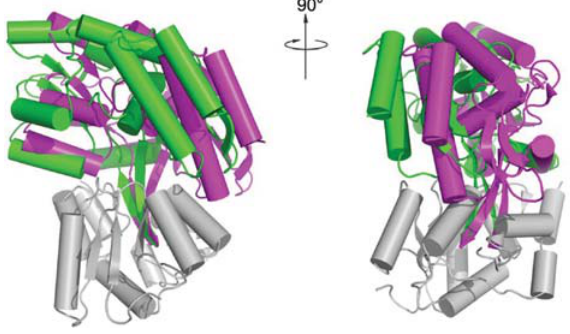
Figure 5 Conformational differences between crystallographic closed-liganded MBP (PDB ID 3MBP; magenta) and the solution, minor, semi-closed-unliganded species (PDB ID 2V93; green). Both structures are superimposed via the N-domain, shown only for the closed-liganded model